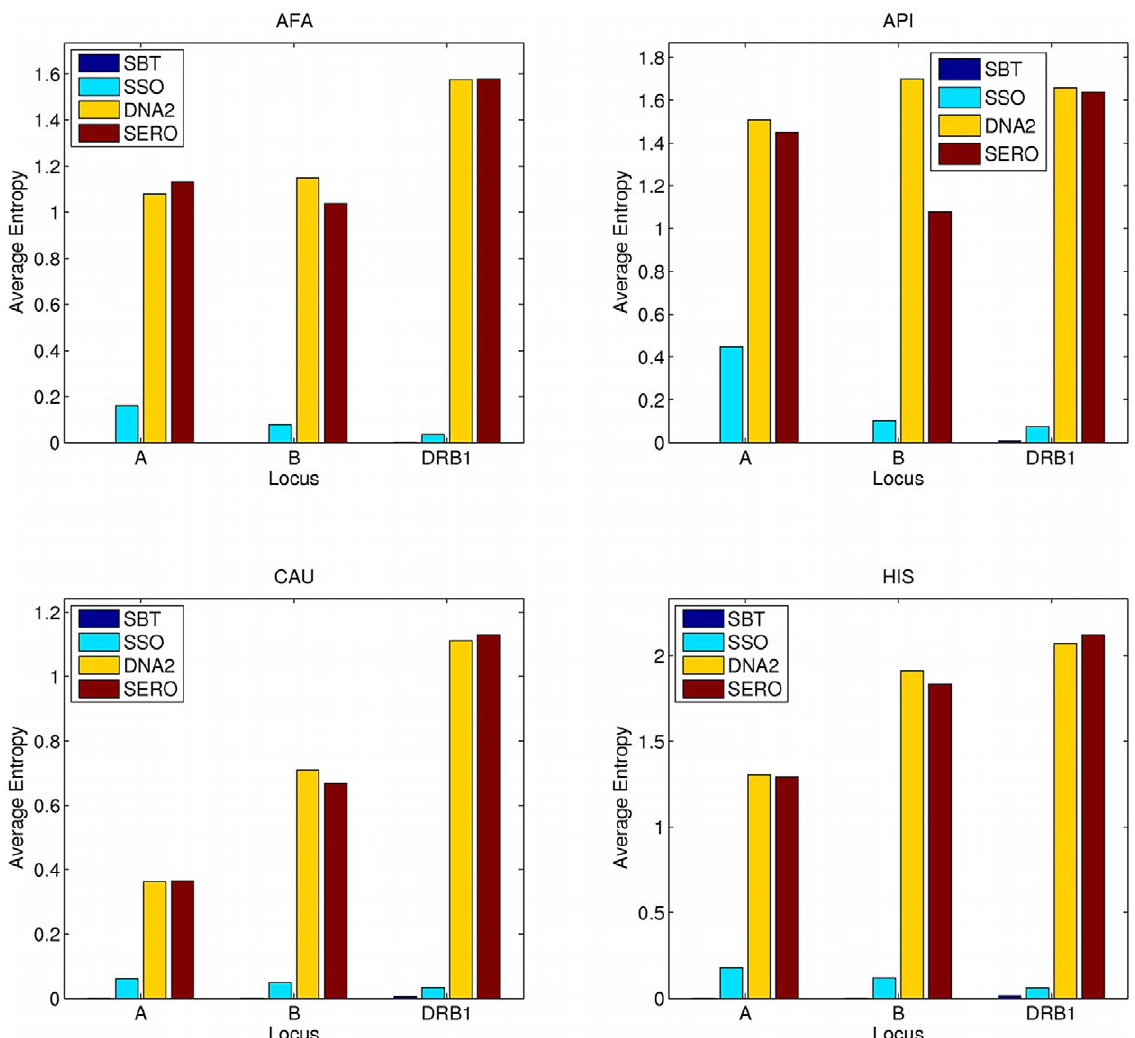
Figure 2. Average haplotype entropy. This figure shows locus entropies obtained for SBT, SSO, DNA2 and SERO typing formats, within each population and for three HLA loci using haplotype frequencies, that is, the haplotype entropy . The four panels correspond to four populations: AFA (African American), API (Asian-Pacific Islander), CAU (Caucasian) and HIS (Hispanic), respectively, from left to right, top to bottom. The y-axis shows entropy averaged across 1000 simulated donor typings, and the x-axis corresponds to the HLA locus that the entropy is measured for (HLA-A, HLA-B and HLA-DRB1). The color represents the typing methods used for typing: SBT (single pass sequence-based typing), SSO (sequence-specific oligonucleotides), DNA2 (two-digit allele family level DNA-based typing) and SERO (serological typing).